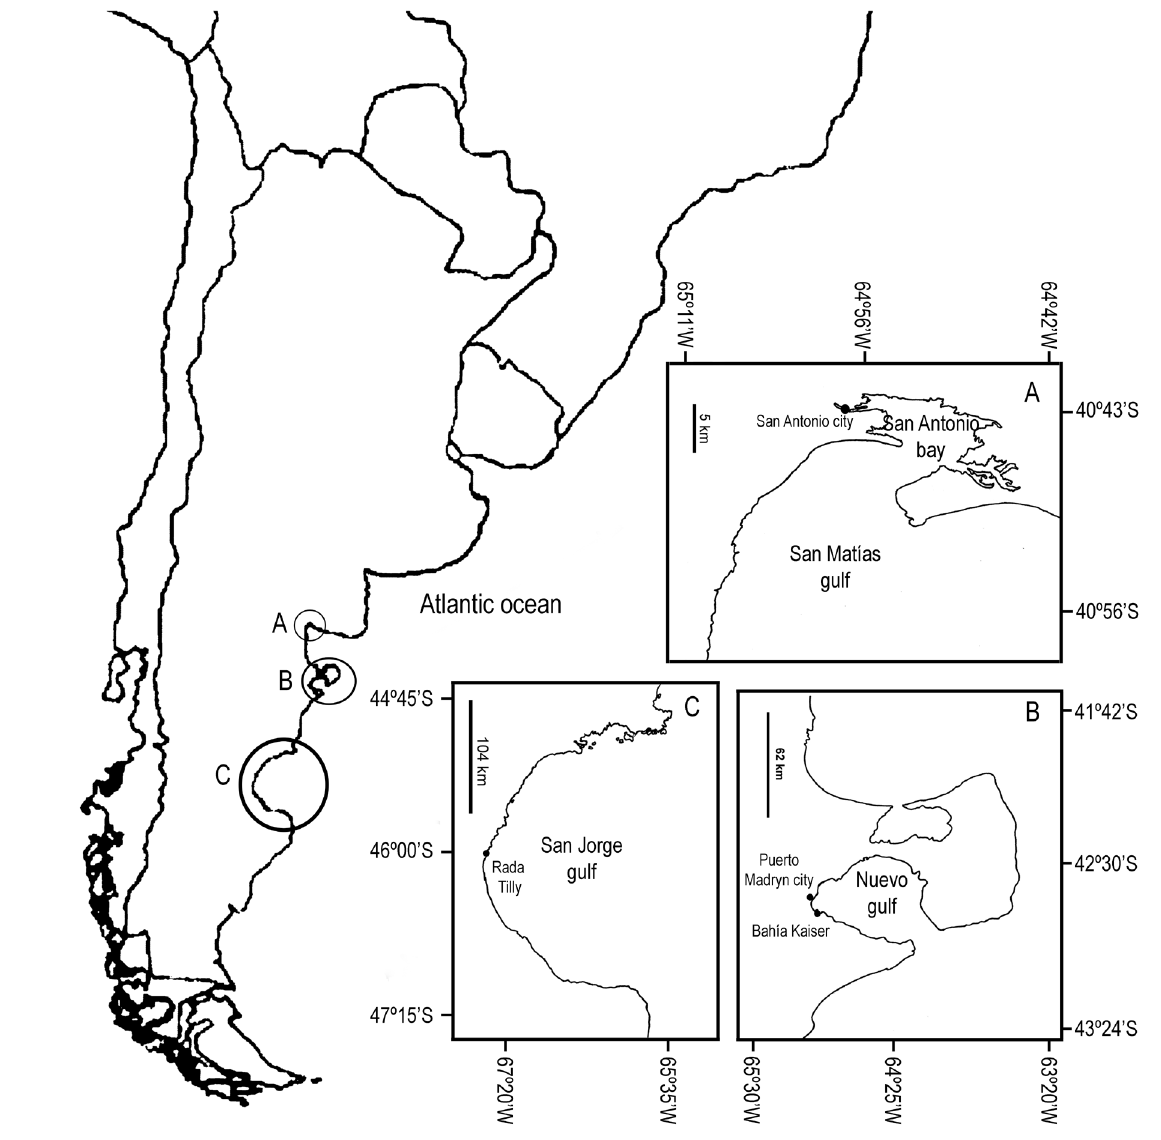
Fig. 1. Map showing the study sites; map of sampling areas. A . ʻSan Antonio Oeste river estuaryʼ, Río Negro Province. B . ʻPuerto Madryn cityʼ and ʻBahía Kaiserʼ, Chubut Province. C . ʻRada Tillyʼ, Chubut